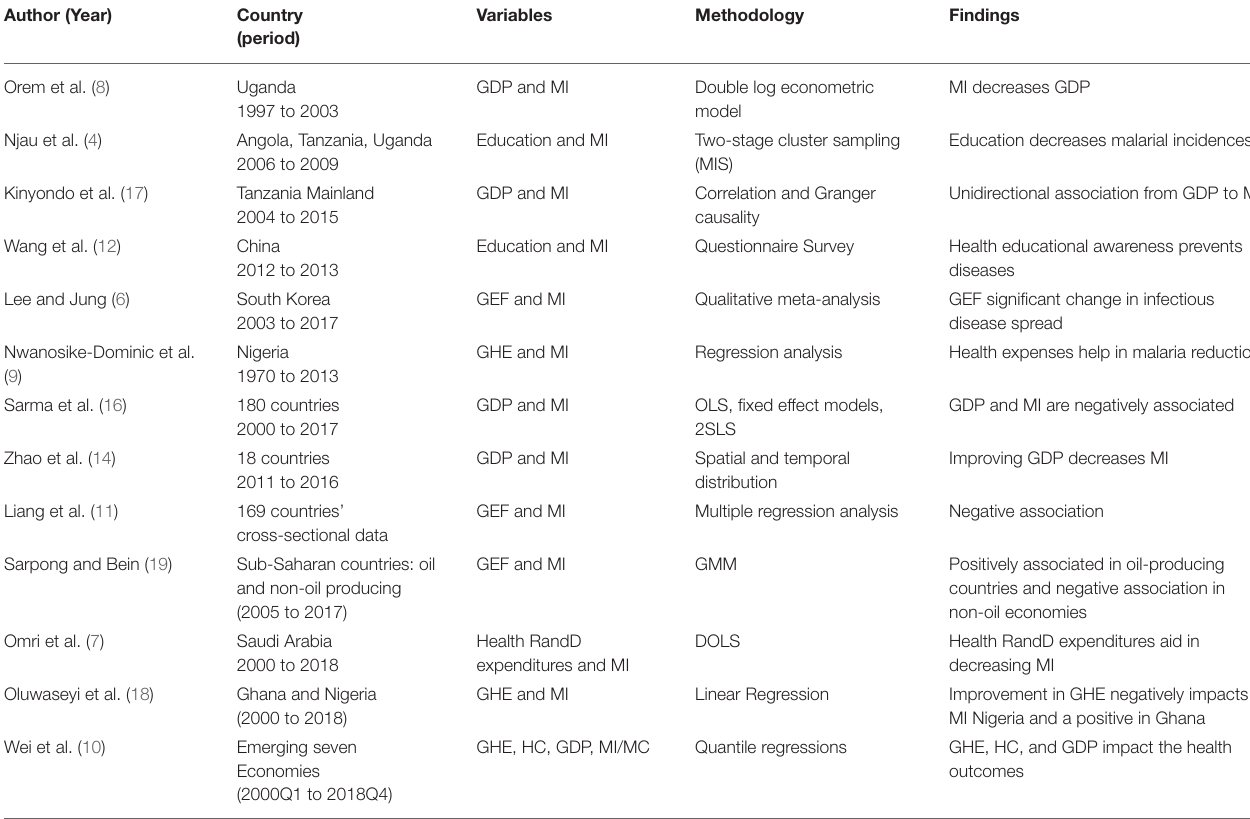
TABLE 1 | Summary of empirical literature